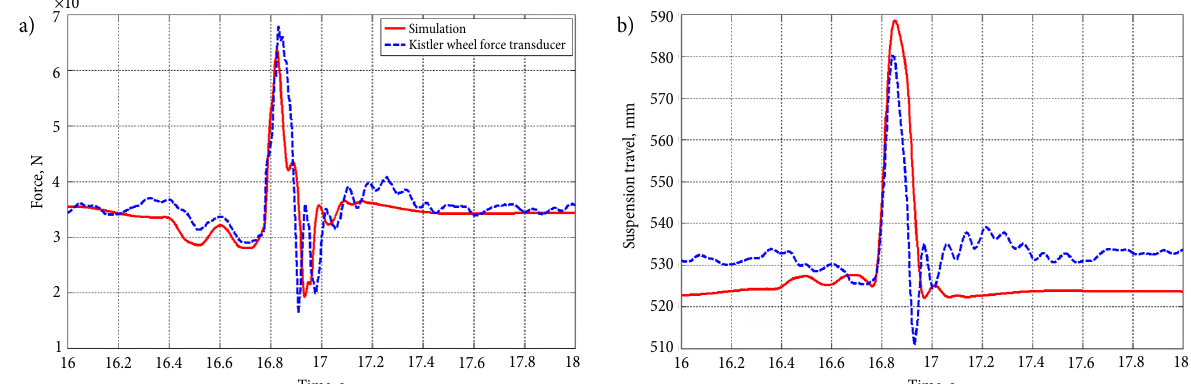
Fig. 10. Wheel forces validation when going over obstacle: a – tyre vertical force when going over the treshold; b – suspension travel when going over the treshold